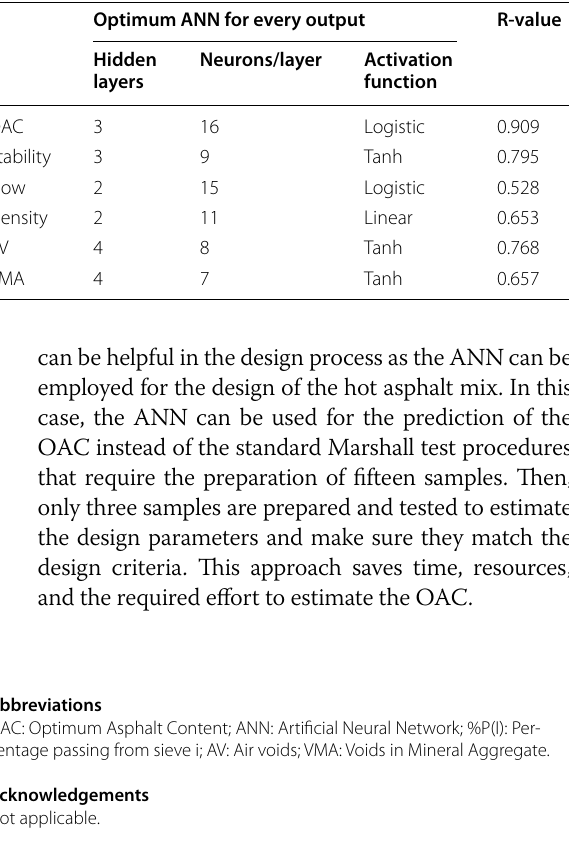
Table 12 Balanced coefficient of correlation for different ANN architectures for the prediction of the asphalt mix volumetric properties Balance